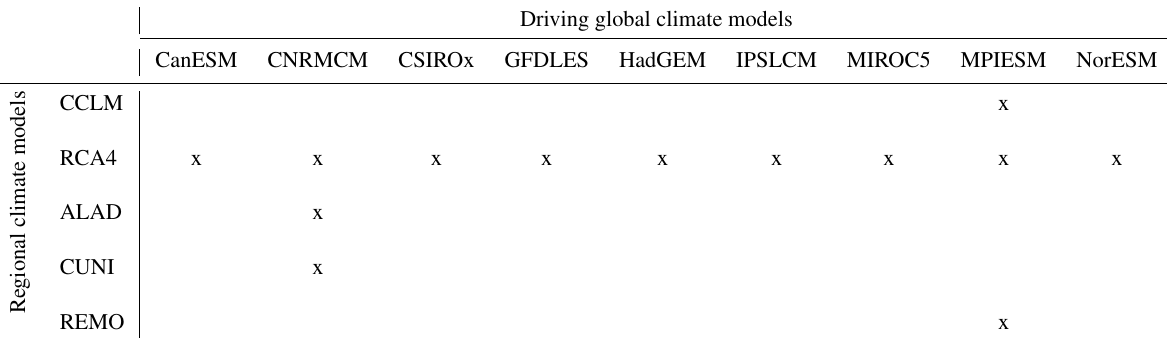
Table 2. Matrix of regional climate model simulations and their driving global climate models that are incorporated in the present